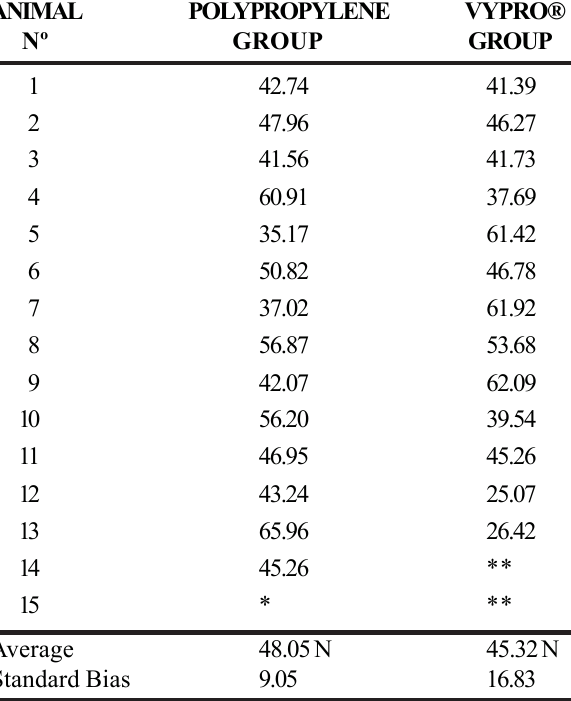
TABLE 1 - Result of traction test of polypropylene and vypro® groups. Force values expressed in Newton.